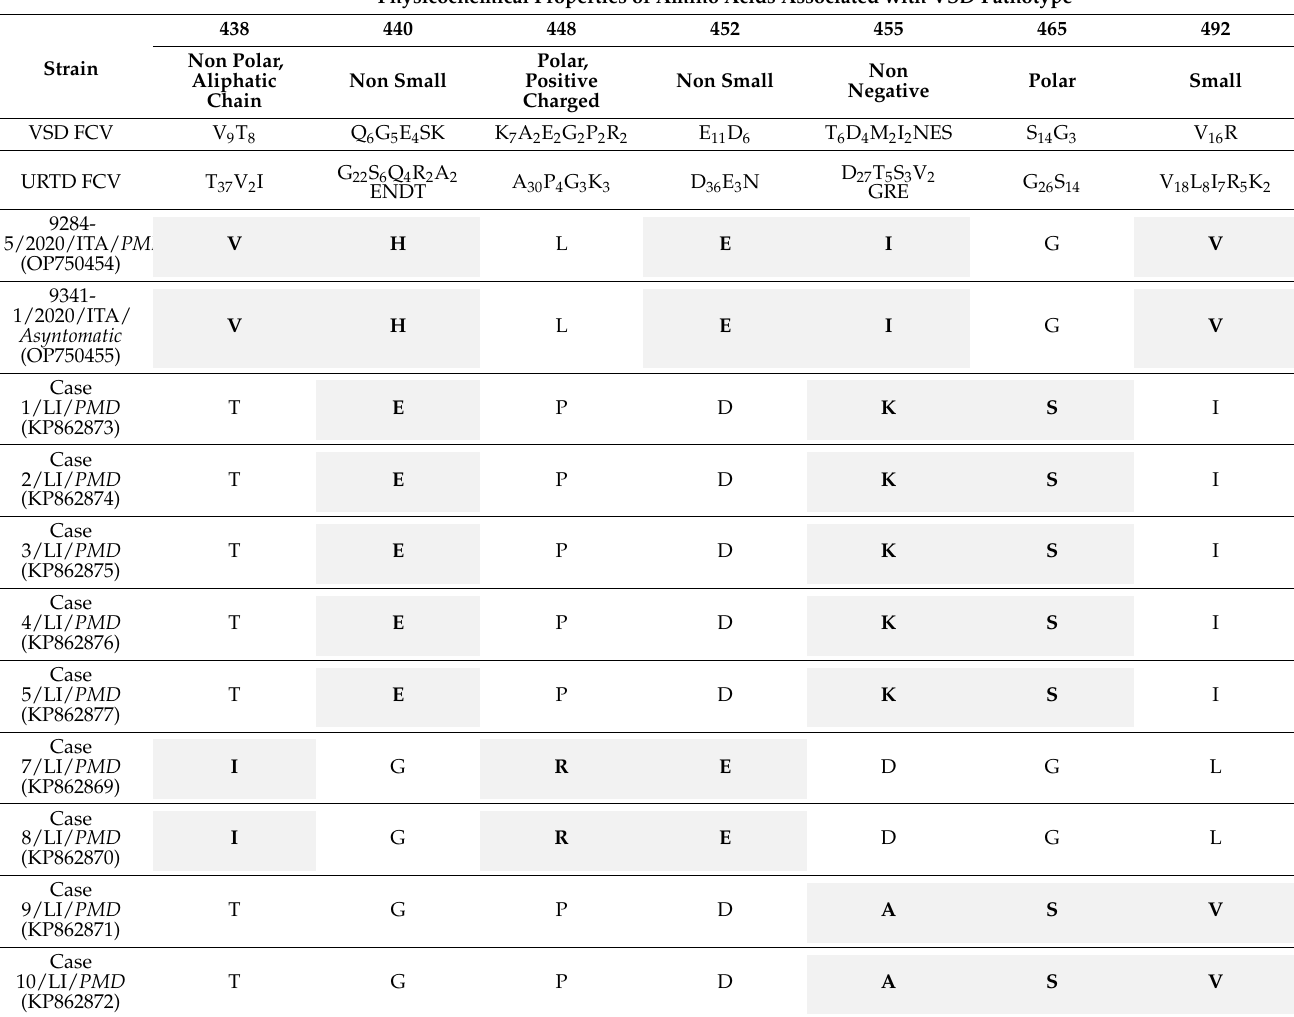
Table 2. Residues of region E of the VP1 capsid protein statistically associated with the VSD-FCV pathotype [46].